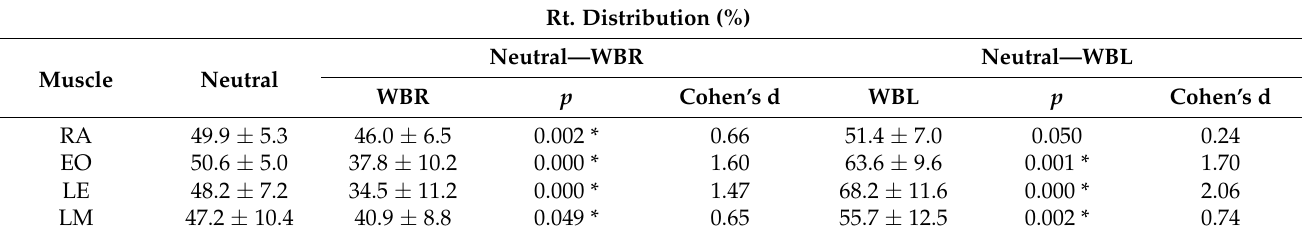
Table 2. Comparison of trunk muscle activity, depending on the weight borne by each hand, using the paired t -test (male, 6 kg dumbbell; female, 4 kg dumbbell) ( n = 27). Rt. Distribution